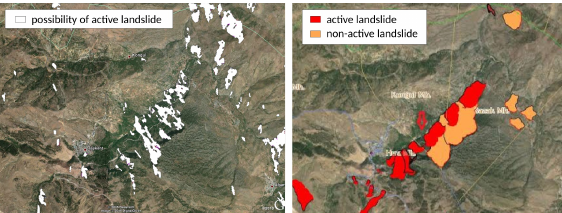
Figure 7. Identification of potentially moving slopes in Taskent town surroundings, Turkey. Left: areas having a coherence of 16/10-10/12/2015 interferogram below given threshold. Right: official landslide inventory (MTA Turkey, 2015).